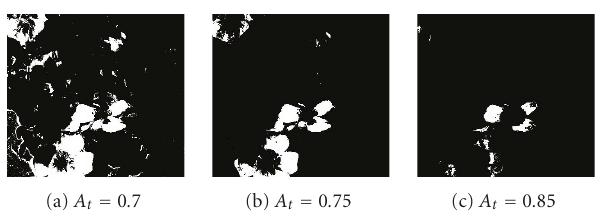
Figure 5: The result of detected image as a function of correlation values A t for lib1. Thirty one input bands are used and processed with one library.